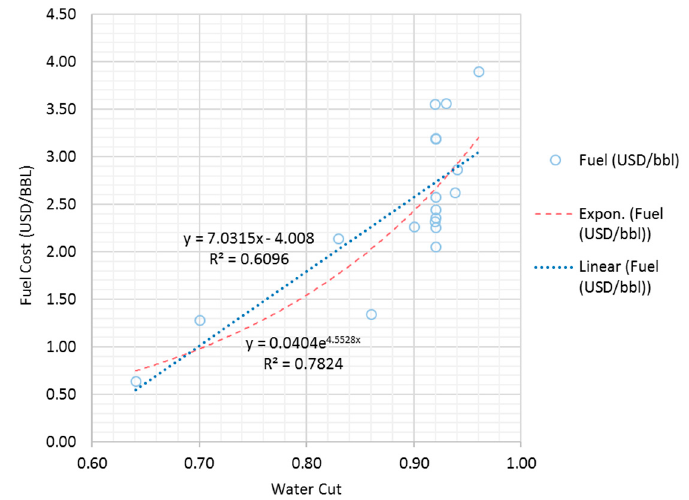
Figure 11. Correlation matrix.